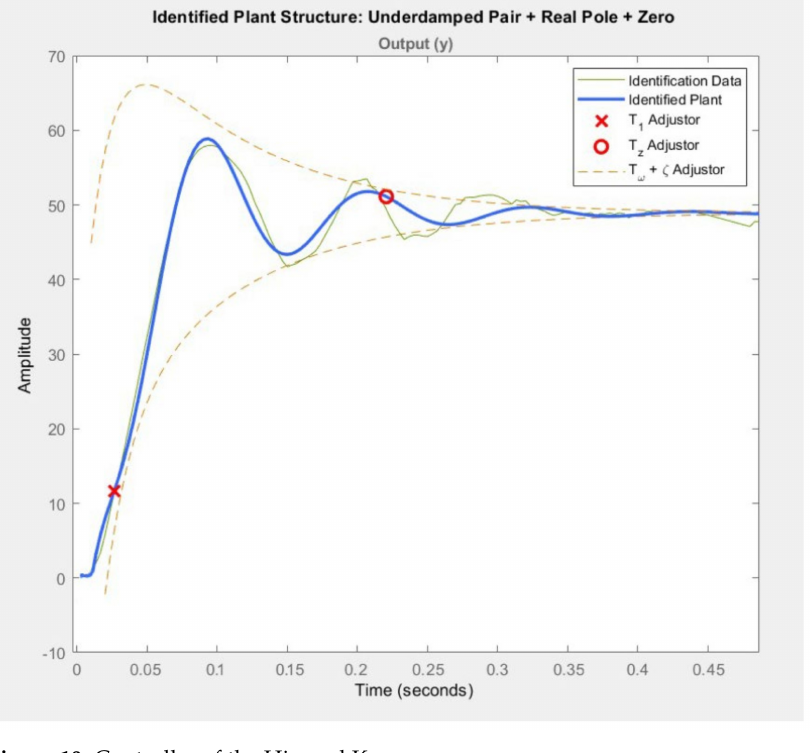
Figure 10. Controller of the Hip and